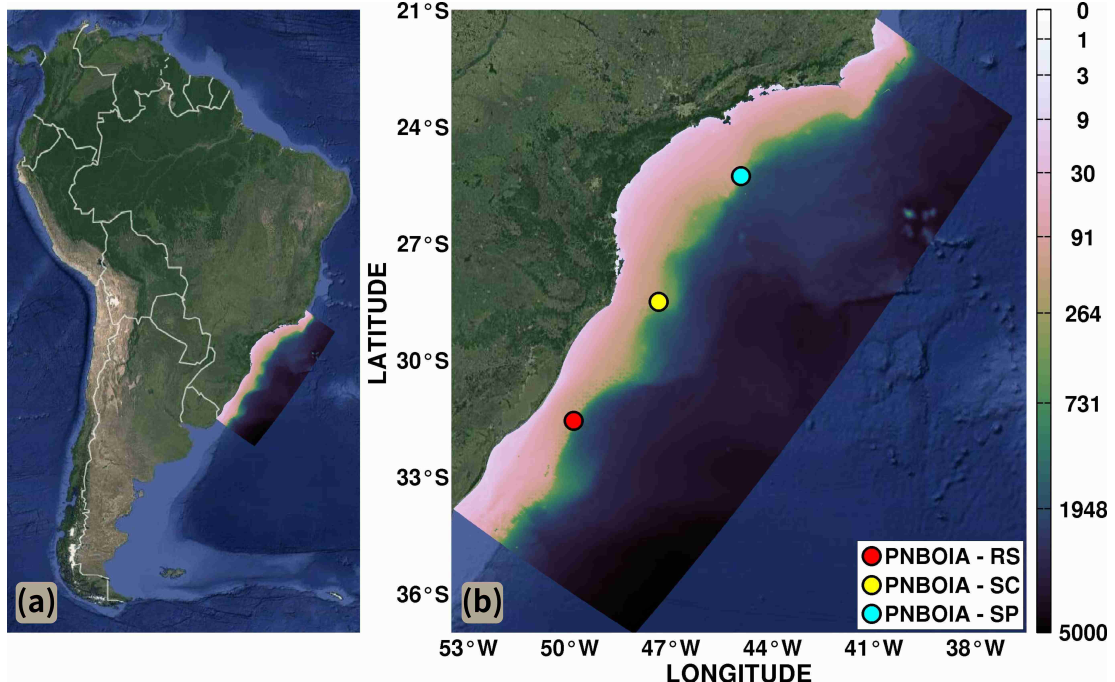
Figure 1. Study region on the south-southeastern Brazilian Shelf ( a ); and location of the wave buoys ( b ). Colour bars represent the bathymetry varying from 0 to 5000m depth. Cube Helix color scheme developed by Green [33]. Satellite images from